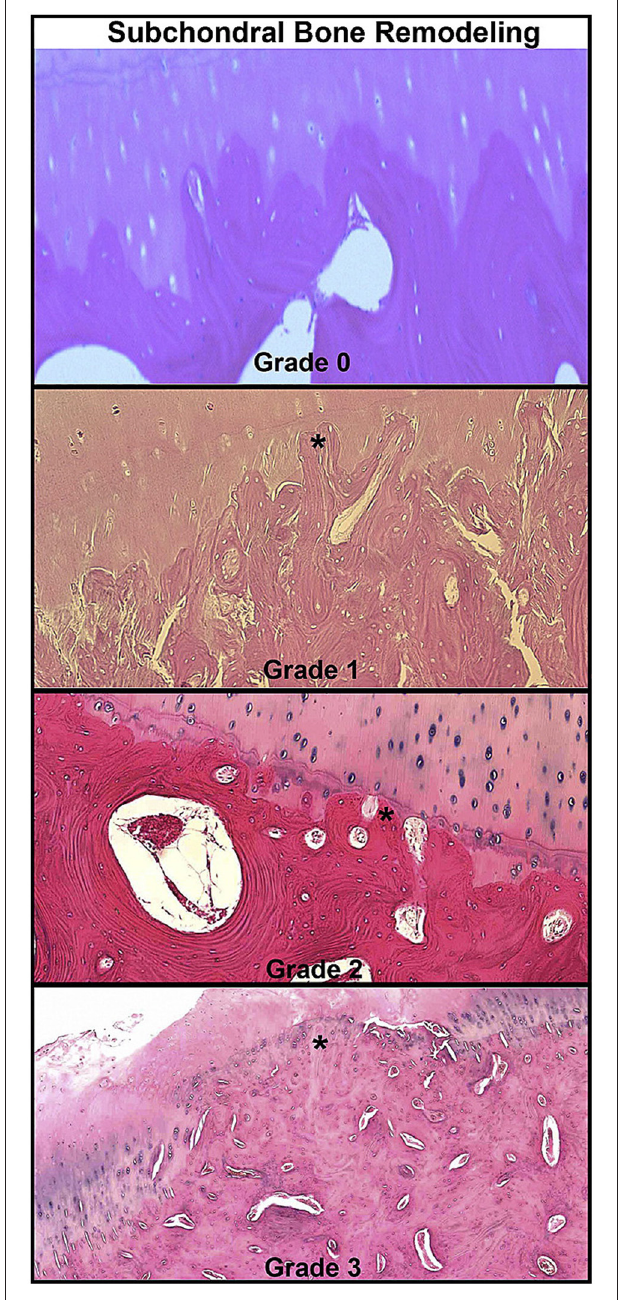
FIGURE 1 | Histopathologic grading examples of osteochondral lesions in spontaneous osteoarthritis cases in equine metacarpophalangeal joints. Microscopic images showing advancement of subchondral bone remodeling through calcified cartilage layer (star). Reprinted from McIlwraith et al. (17), with permission from